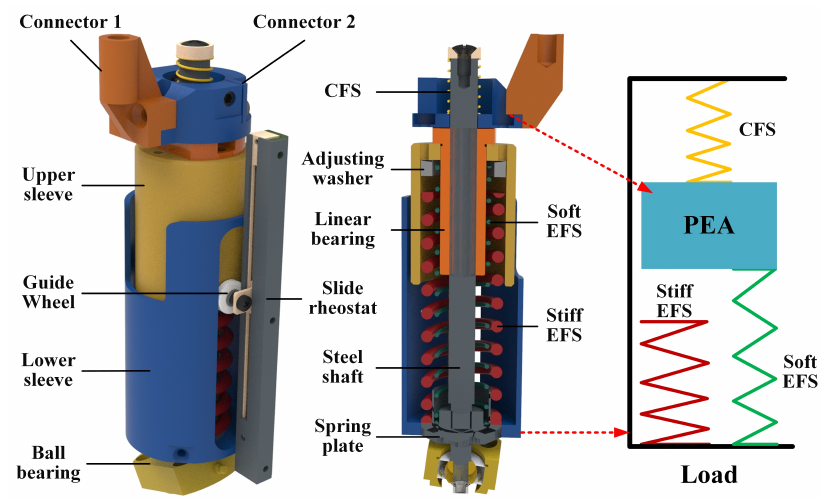
Figure 5. Mechanical structure of the SEM. The connector 1 and connector 2 in the figure is used to connect to the gas spring and the telescopic cylinder.